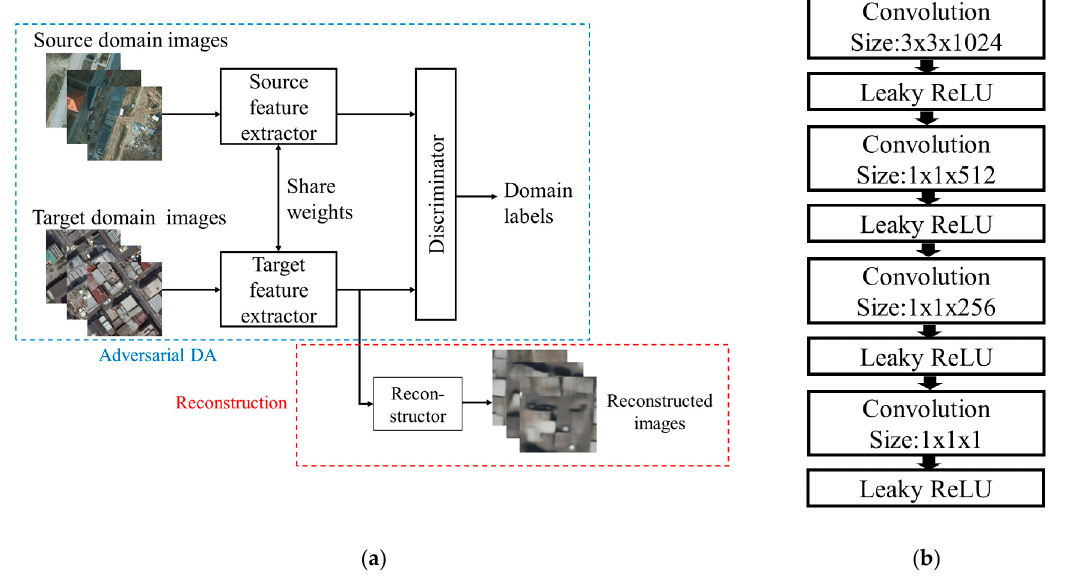
Figure 3. Overview of adversarial DA: ( a ) algorithm and ( b ) discriminator network. Leaky ReLU is a variant of the activation function called rectified linear unit (ReLU).